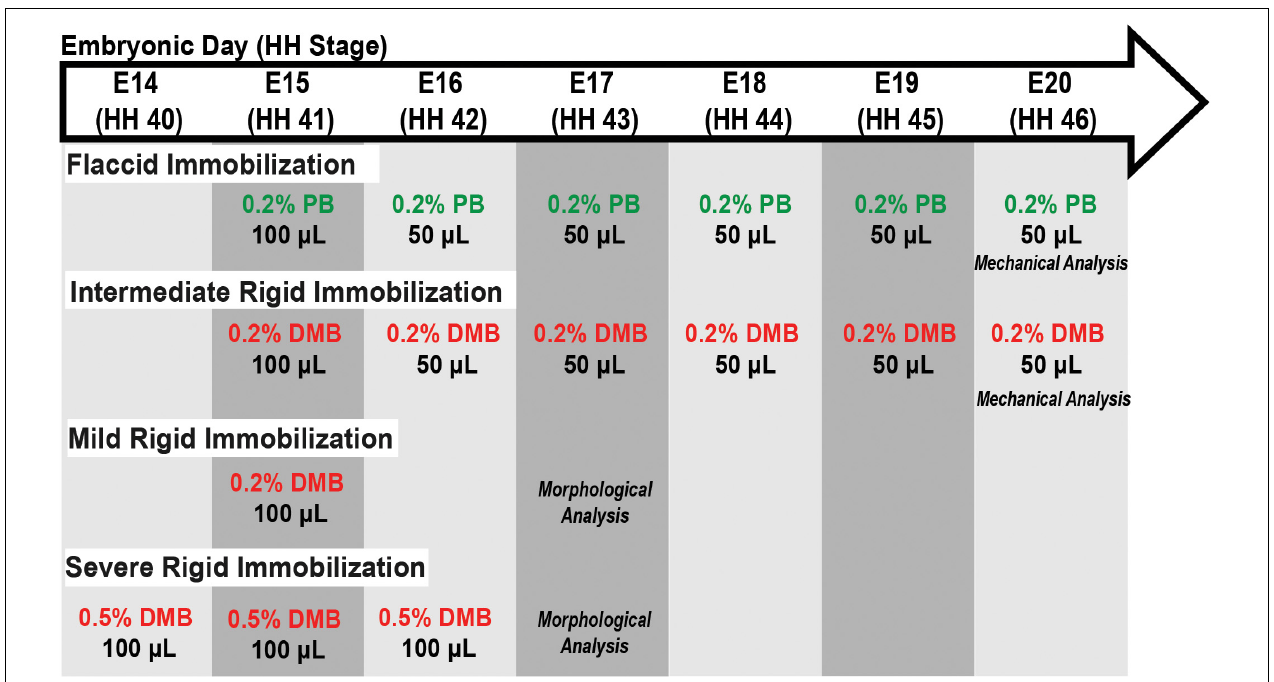
FIGURE 1 | Schematic of immobilization treatment regimens, as indicated by the specific drug and their respective concentration, volumes, and embryonic day (E) in which treatment was administered. Embryos sacrificed for either mechanical or morphological analysis as indicated. Abbreviations: HH, Hamburger and Hamilton stage; DMB, Decamethonium Bromide; and PB, Pancuronium